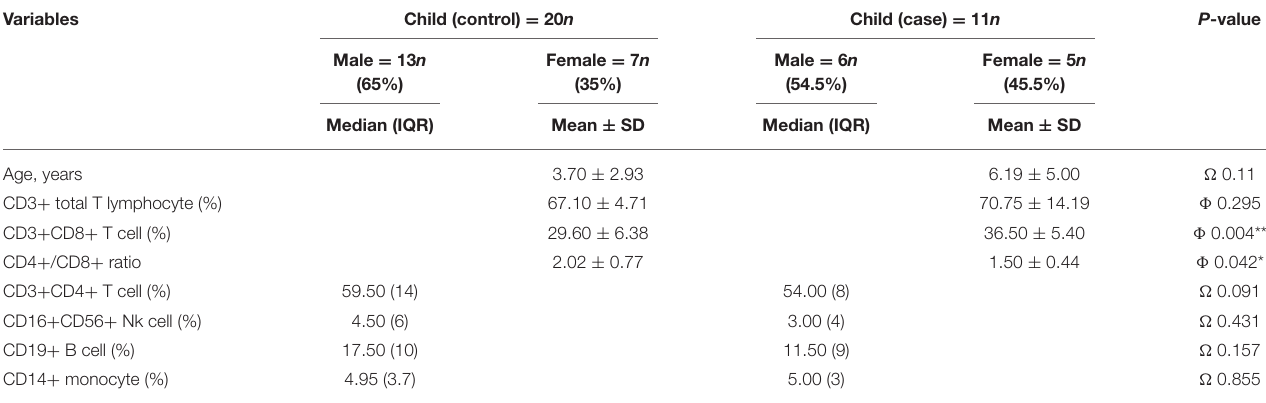
TABLE 3 | Comparison of peripheral innate and adaptive immune cells of COVID-19 children patients with healthy children.